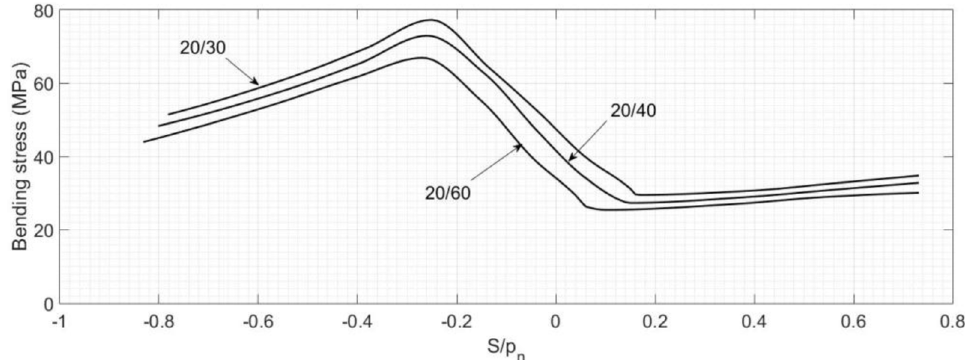
Fig. 19. Variation of the bending stress at the tooth fi llet for the 20/30, 20/40 and 20/60 plastic/steel gear